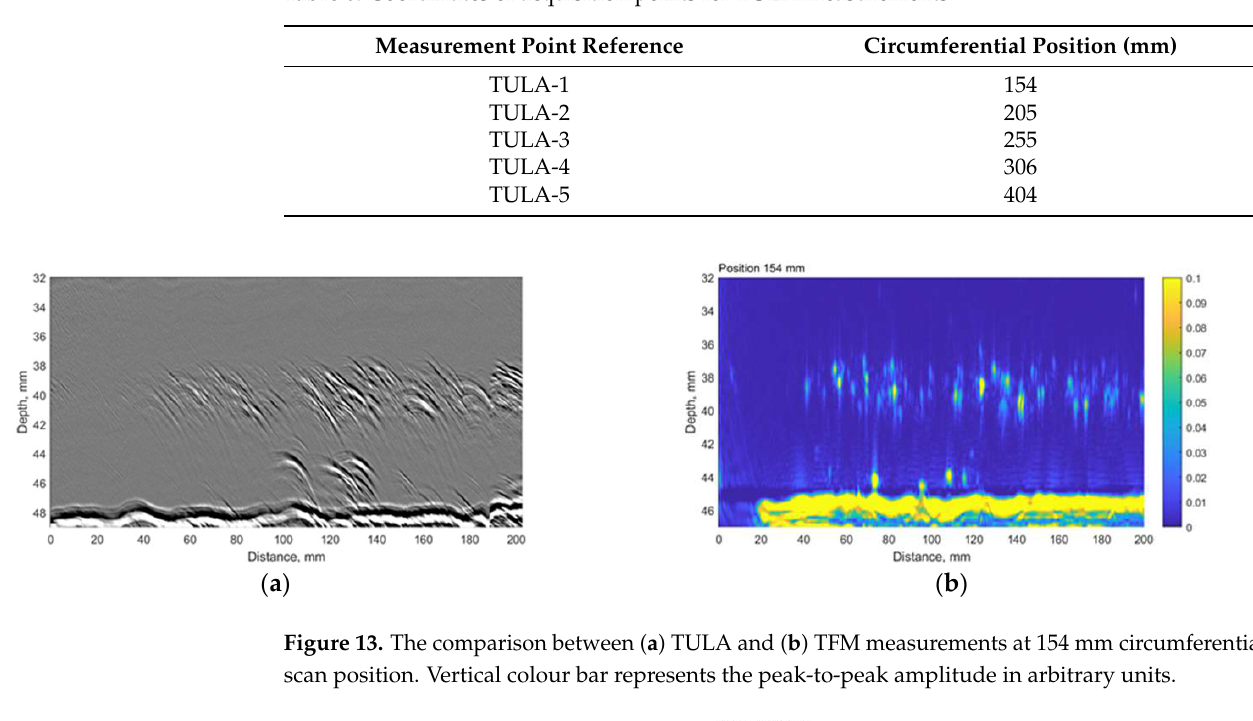
Table 6. Coordinates of acquisition points for TULA measurements.